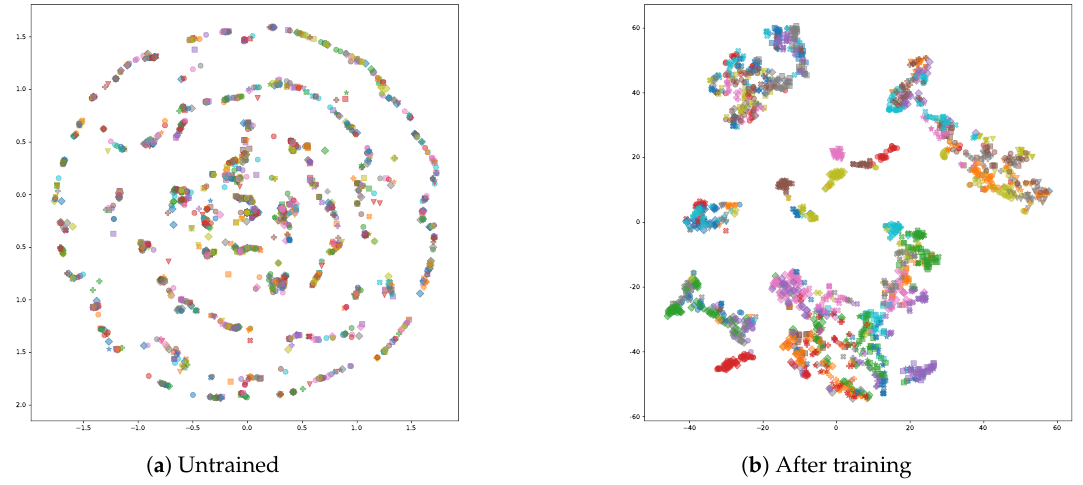
Figure 11. t-SNE [67] based visualization of the 128-dimensional embedding vectors from the test dataset in two-dimensions. Subfigure ( a ) illustrates the point-cloud before training, while subfigure ( b ) visualizes it afterwards. For the transformation perplexity was set to 30 and the learning rate to